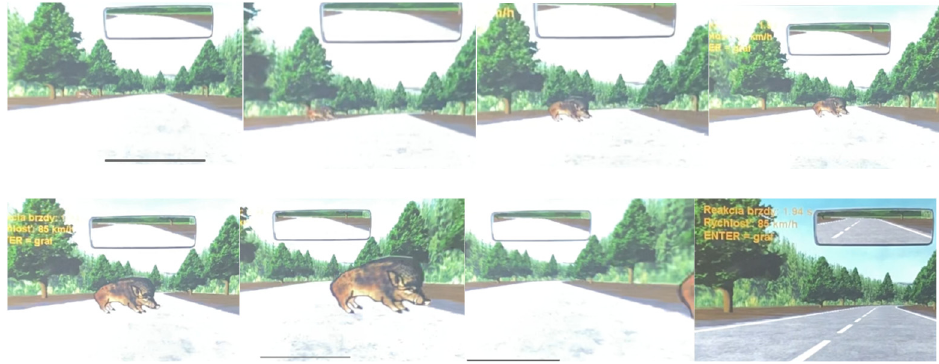
Figure 4. Simulator with the appearance of a wild boar on the screen. Source: own collaboration.